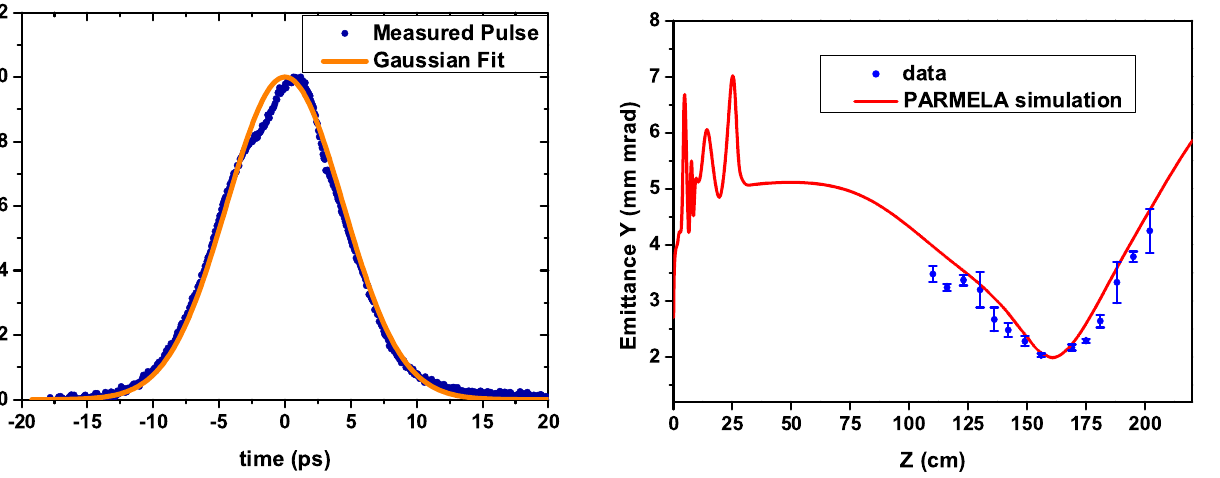
FIG. 12. (Color) Emittance measurement using the longitudinal laser pulse shape of Fig. 11. A PARMELA simulation is also shown for